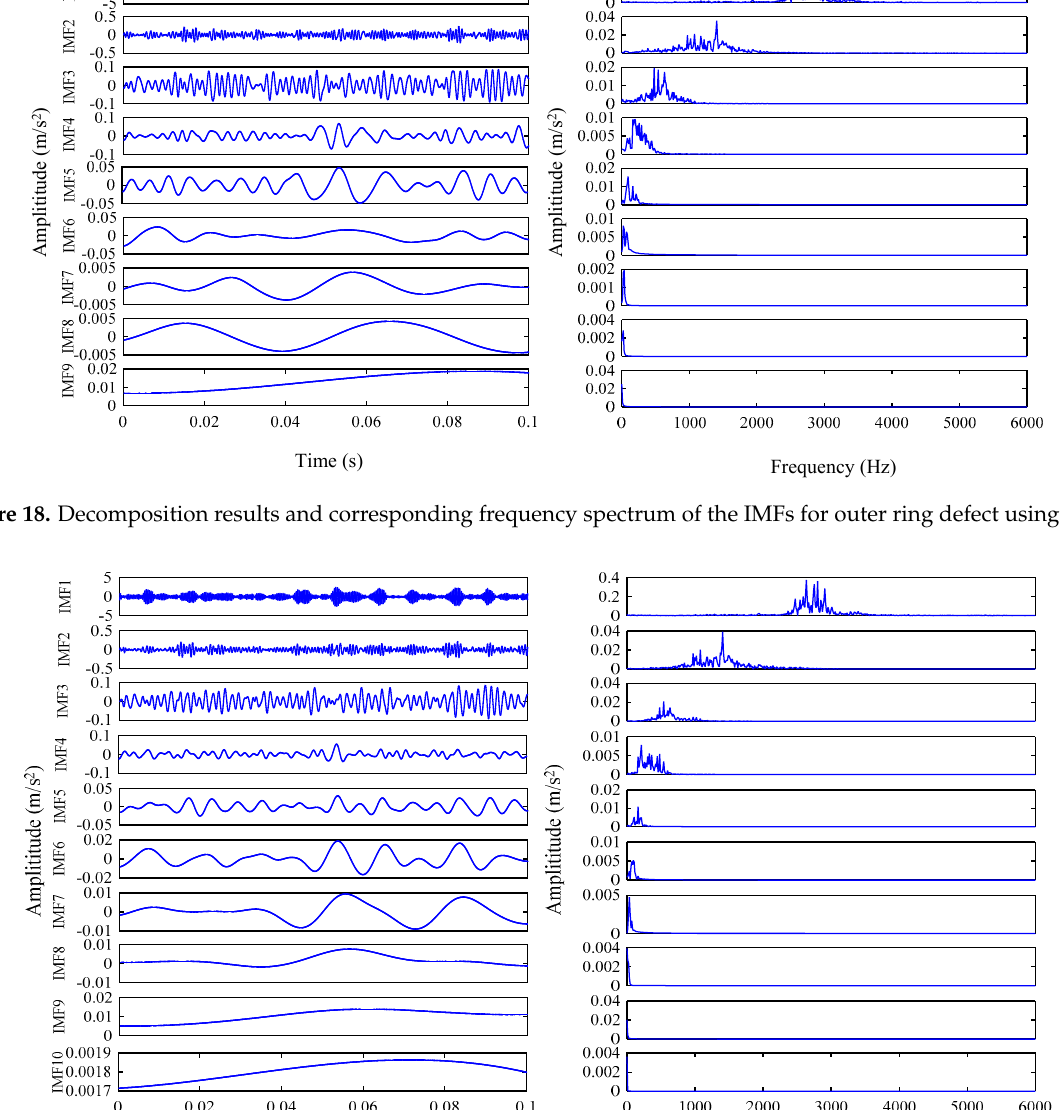
Figure 20. Decomposition results and corresponding frequency spectrum of IMFs for outer ring defect with CEEMD.